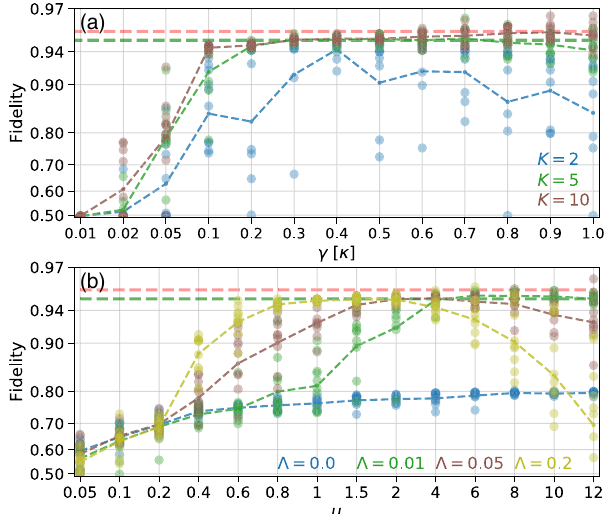
FIG. 7. Performance as a function of various hyperparameters. In (a) we vary the RC timescale γ for RCs with K ¼ 2 , 5, and 10 ¯ Λ nodes, with μ ¼ 5 and ¼ 5 × 10 − 2 . Panel (b) shows fidelity as ¯ Λ a function of input coupling strength μ and nonlinearity for K ¼ 5 networks with γ ¼ 0 . 5 κ . In all plots α ¼ 1 . 9 and the RCs are trained with Q ¼ 80 measurements. Ten different random networks are shown in (b), and 10 for each K in (a), with individual F in colored circles, and the average fidelity as a dashed line. The fidelity of the boxcar and analytic MF are indicated in green and red dashed lines as in previous